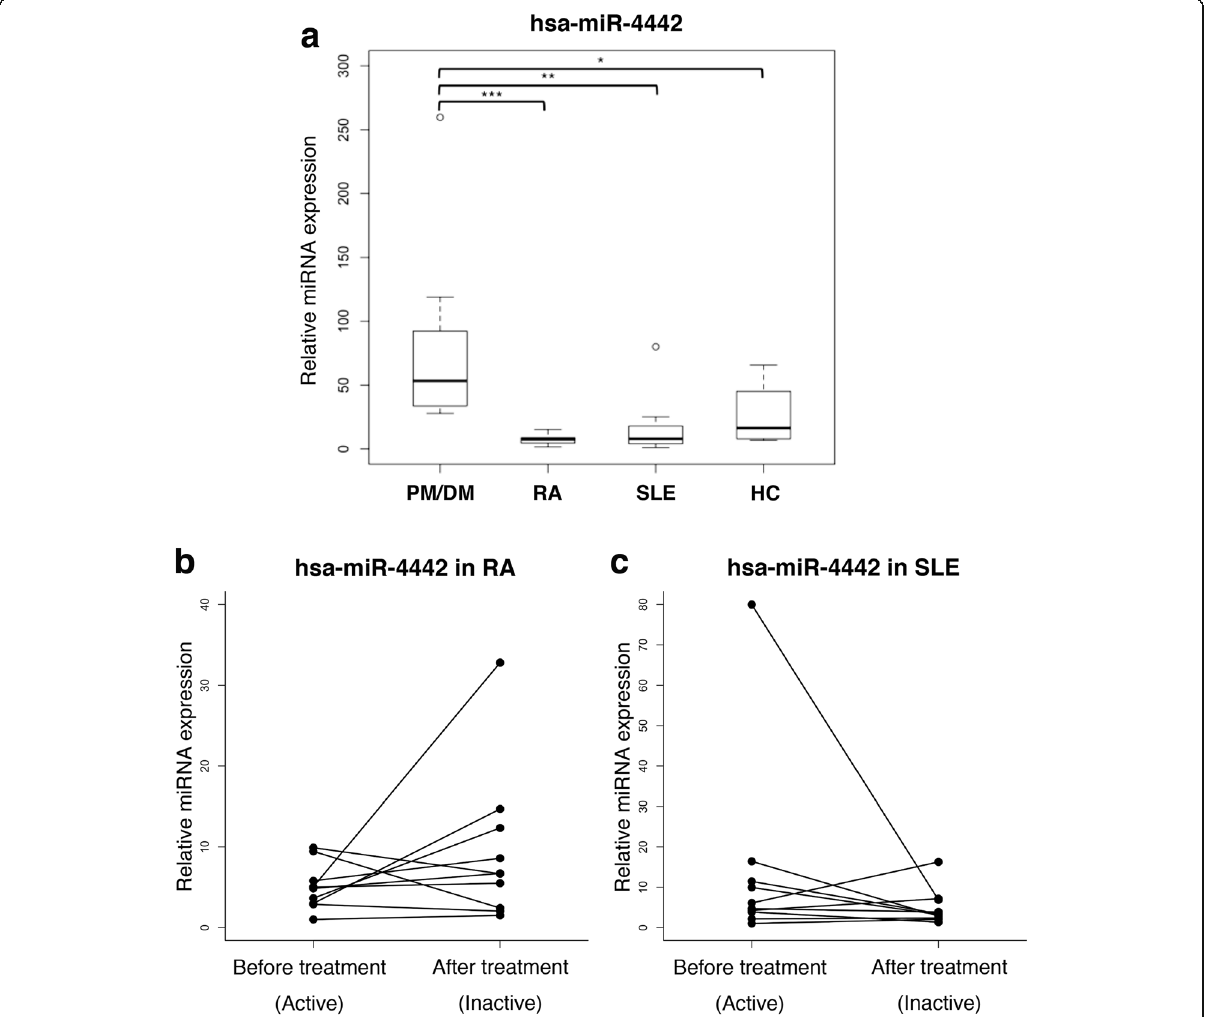
Fig. 4 a Comparison of plasma hsa-miR-4442 expression between active PM/DM and RA, SLE, and healthy individuals using qRT-PCR. The expression of hsa-miR-4442 was significantly higher in PM/DM compared to RA, SLE, or healthy controls (* P <0.05, ** P <0.01, and *** P <0.001, respectively). b , c Quantitative RT-PCR was performed to confirm the differential expression of has-miR-4442 in plasma of before (active)/after treatment (inactive) RA and SLE patients. There was no statistically significant difference in either patient. PM/DM: polymyositis and dermatomyositis ( n =10); RA: rheumatoid arthritis ( n =10); SLE: systemic lupus erythematosus ( n =12); HC: healthy control ( n